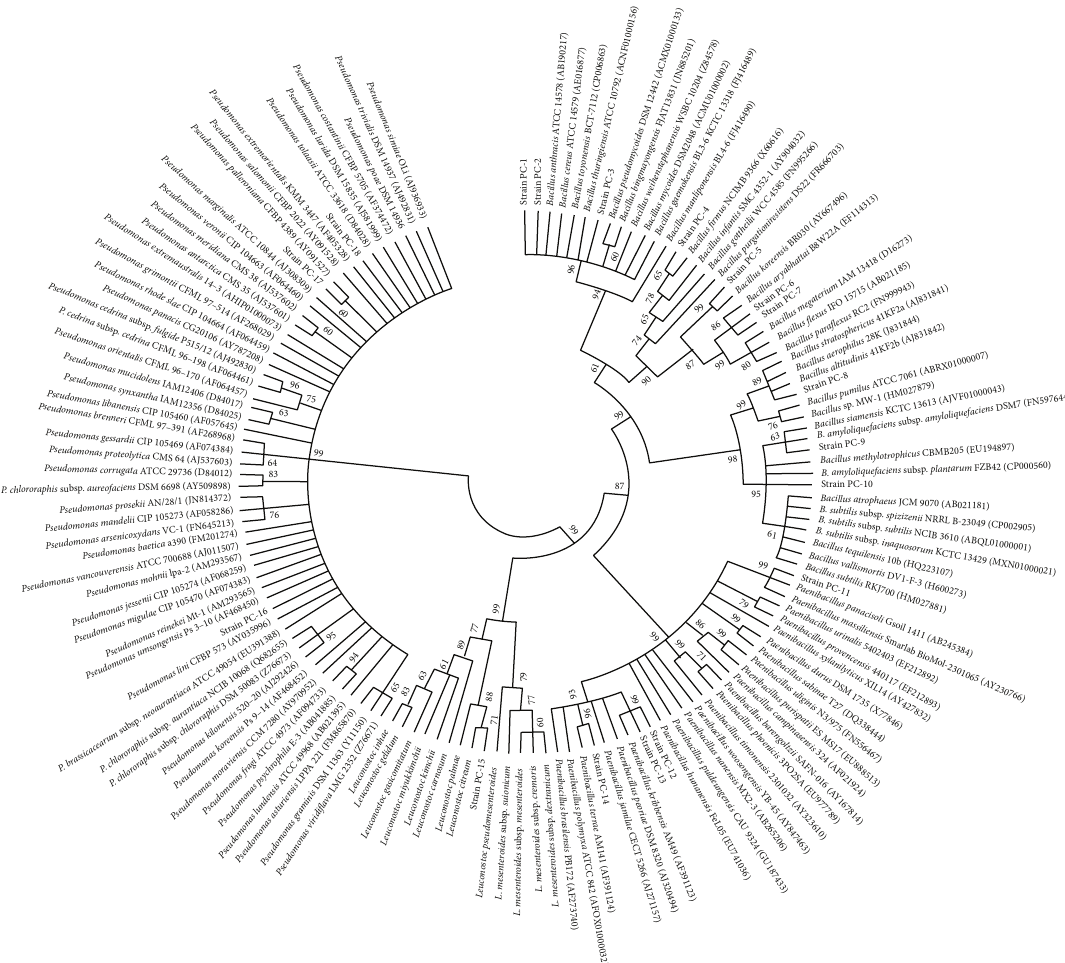
Figure 1: Phylogenetic tree of 4-chloro-2-nitrophenol-decolorizing bacteria based on their 16S rRNA